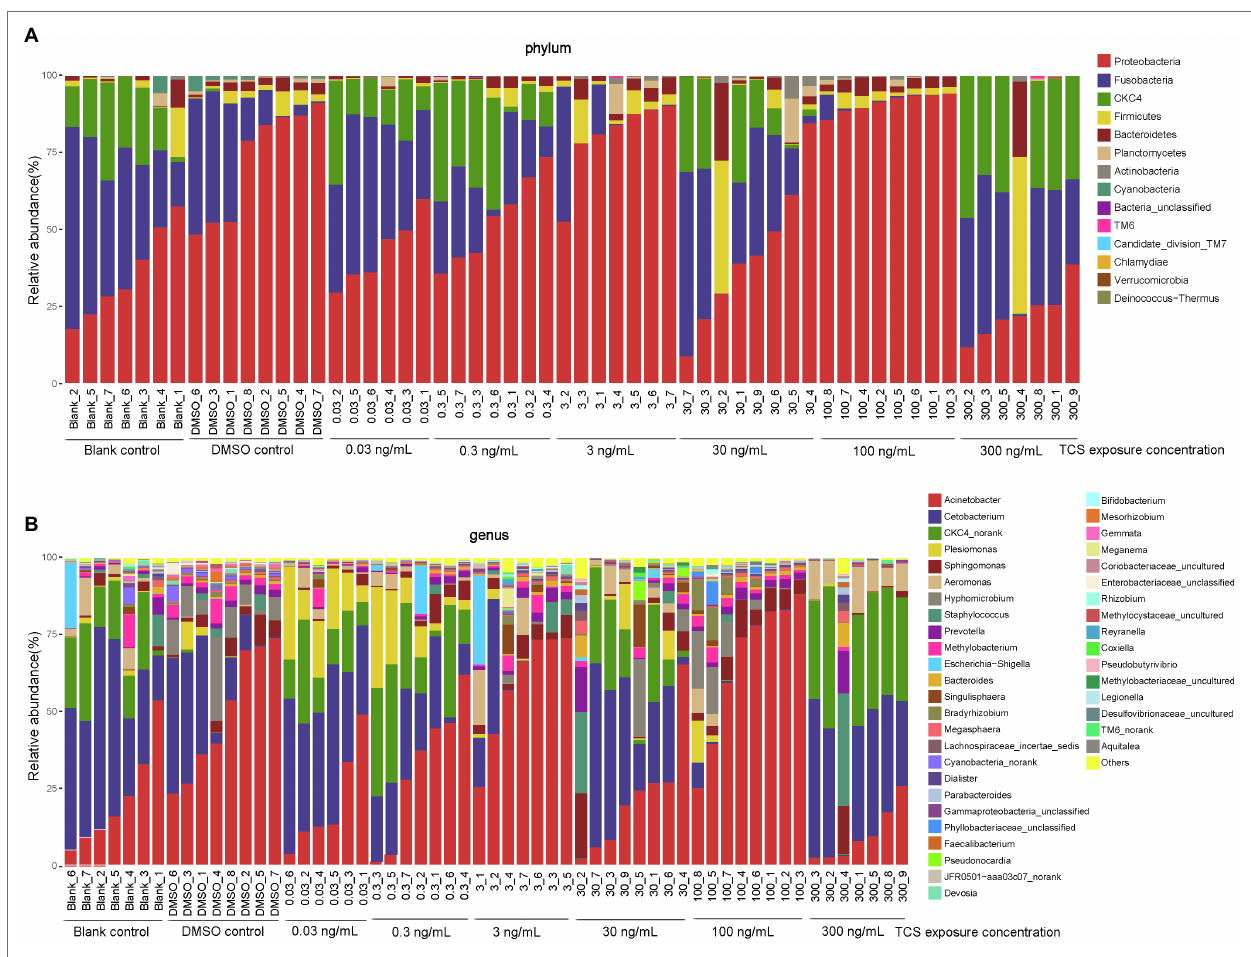
Figure S3 ) of microbiota in adult zebrafish between TCS exposure groups and DMSO control. Similarly, phylum Proteobacteria, Fusobacteria, Actinobacteria, Firmicutes, Bacteroidetes, and Cyanobacteria accounted for 95.6% of microbiota ( Supplementary Figure S4A ). The relative abundance of the top 2 most dominant phyla, Proteobacteria, and Fusobacteria accounted for 90.5% and showed no difference among the DMSO control group and all TCS exposure groups ( Supplementary Table S1 ). Compared with the DMSO control, the relative abundance of phylum Tenericutes was higher in the TCS 0.03 ng/ml group. The